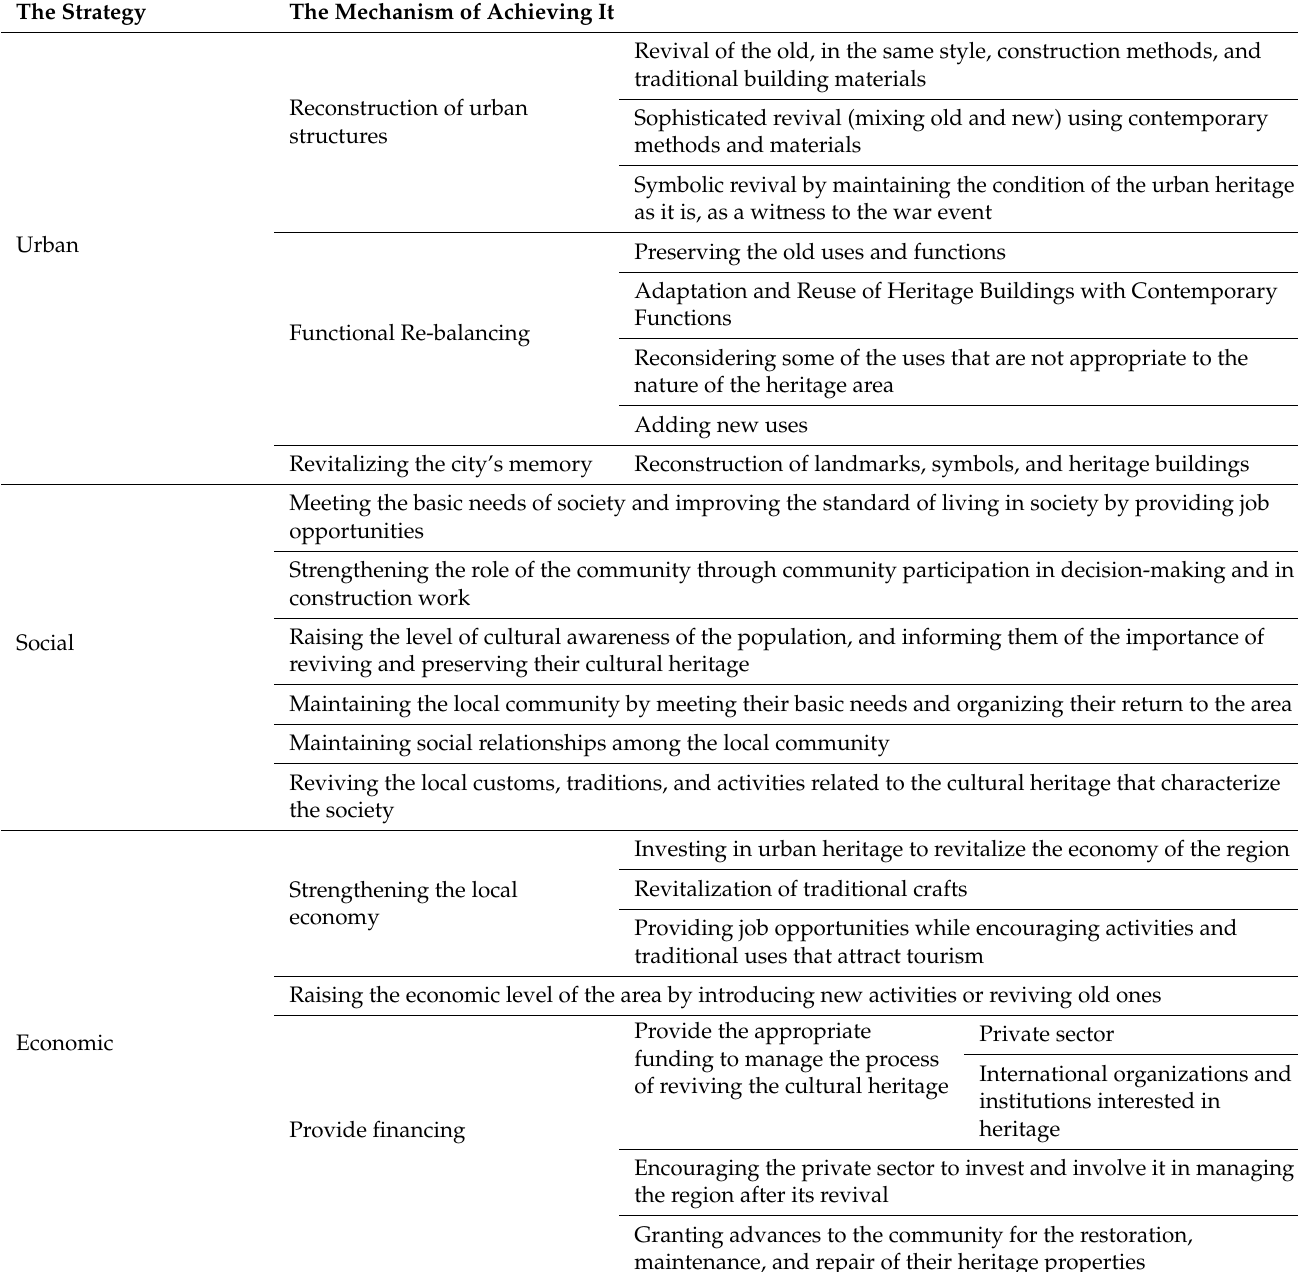
Table 1. The most important indicators for the revival of cultural heritage after